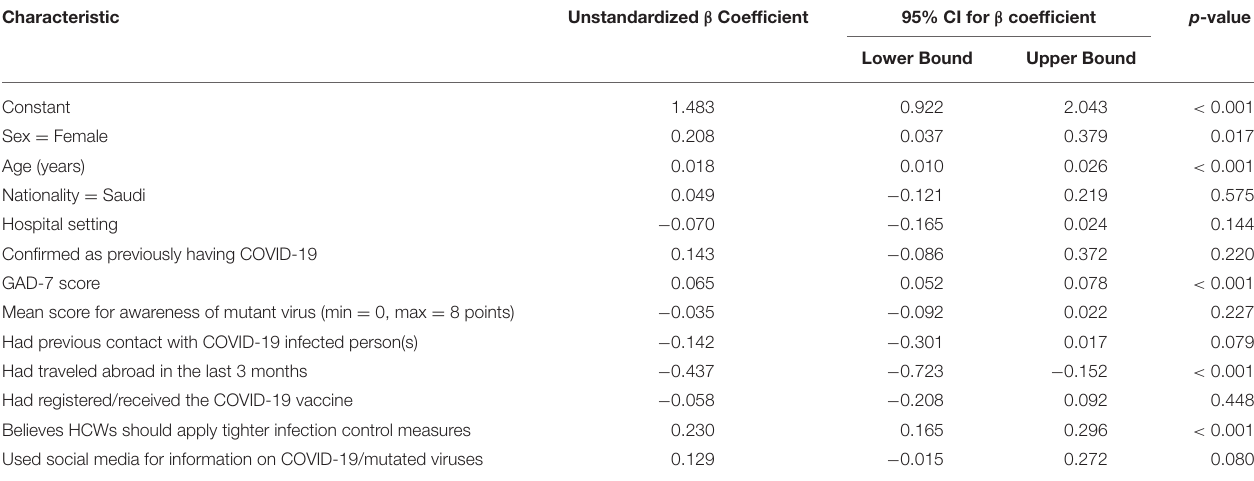
TABLE 5 | Multivariate linear regression analysis of HCWs’ level of worry regarding traveling abroad ( N = 1,058).